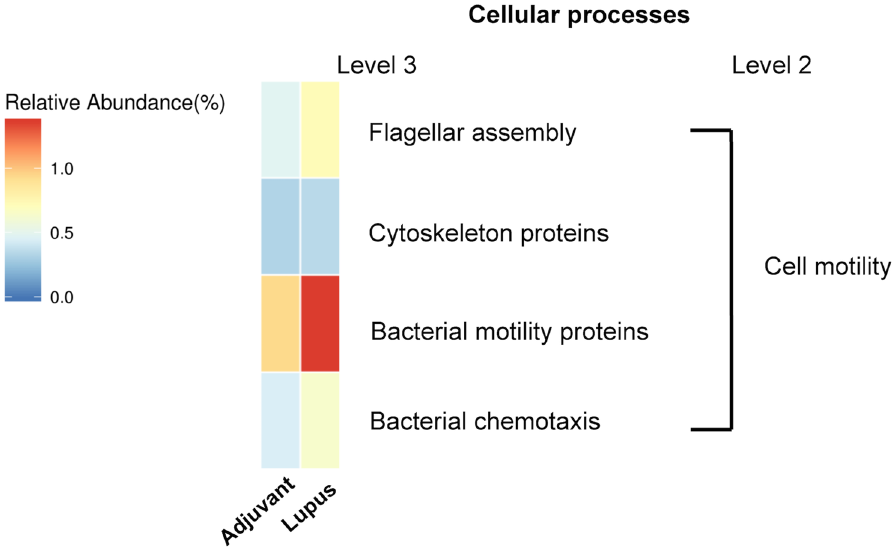
Figure 5. Metagenomic taxonomic profiling of microbial communities in the adjuvant and lupus groups by phylogenetic reconstruction of unobserved states (PICRUSt).